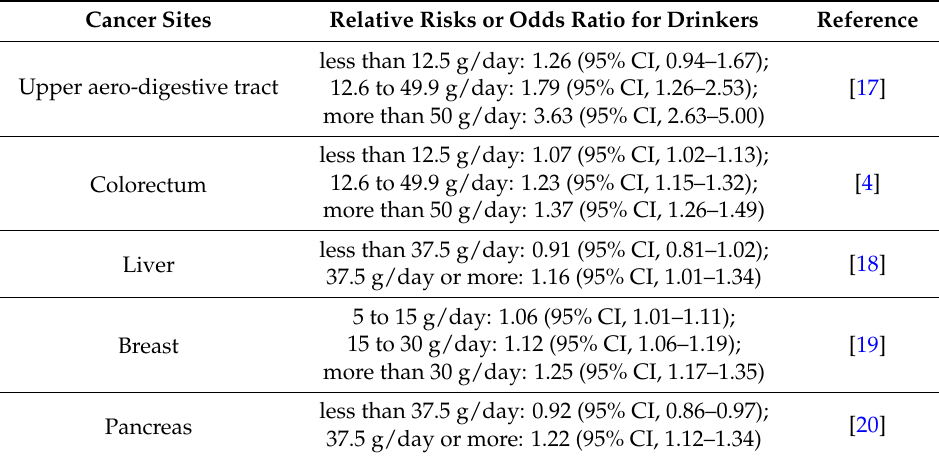
Table 1. Risks of cancer at different sites with alcohol